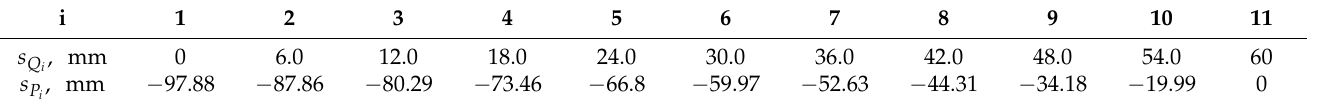
Table 1. Positions of the input and output sliders.